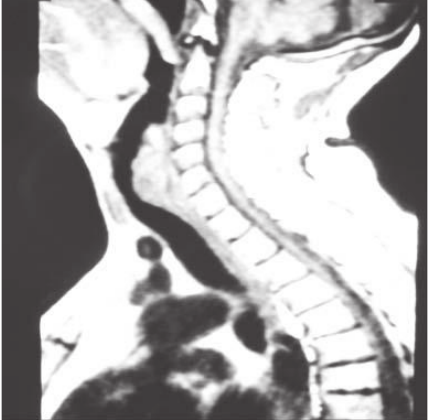
Figure 2: MRI of neck. Laryngeal mass, starting from the region of the left vocal cord and expanding in the trachea until the level of 4th thoracic